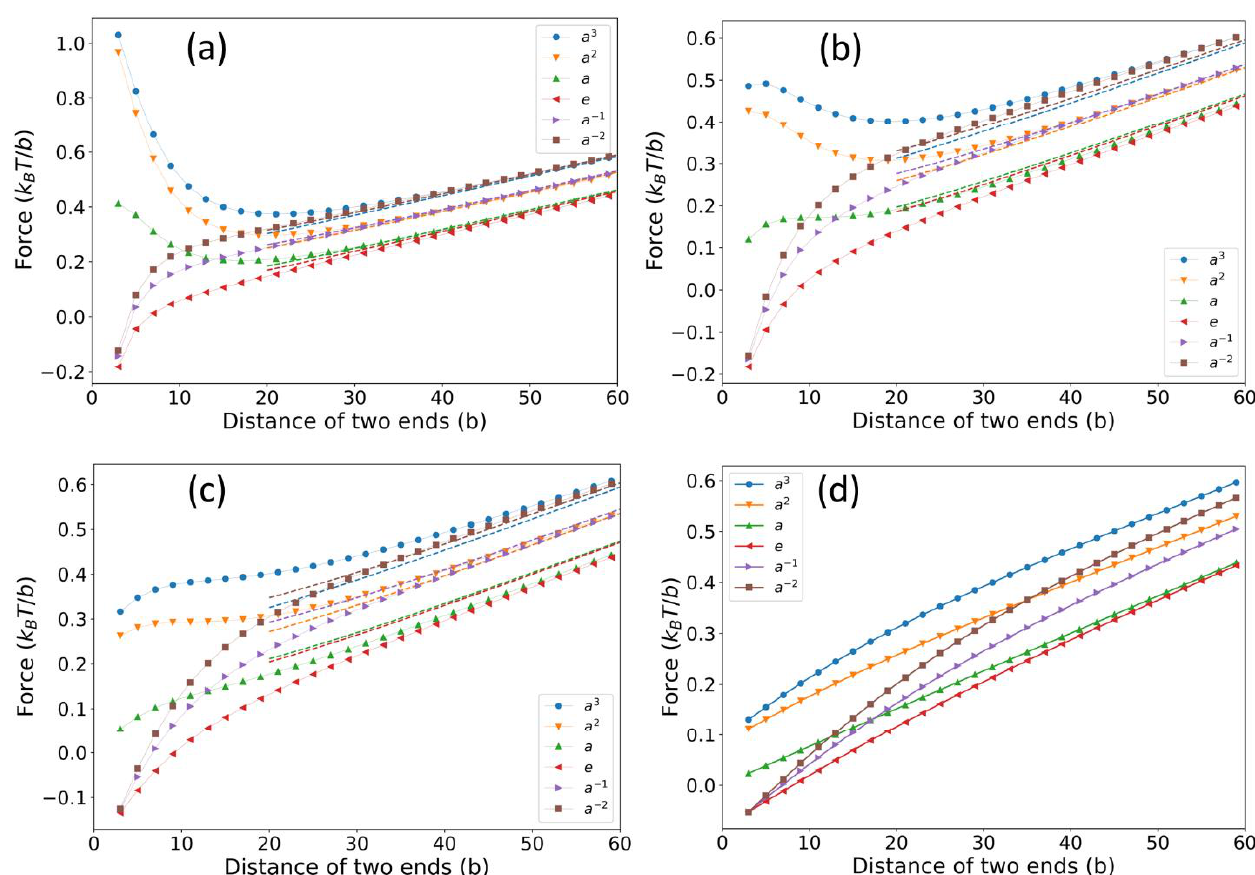
Figure 6. Force-extension curves of an ideal chain entangled with a ring with the overall radius of ( a ) R = 2 b , ( b ) R = 4 b , ( c ) R = 6 b , and ( d ) R = 16 b . Six different entangling modes (see Figure 5), corresponding to six curves in each plot, have been explored. The results obtained by superspace approach are given by full circles (with solid lines) while the results obtained by the blob model are given by dashed lines.